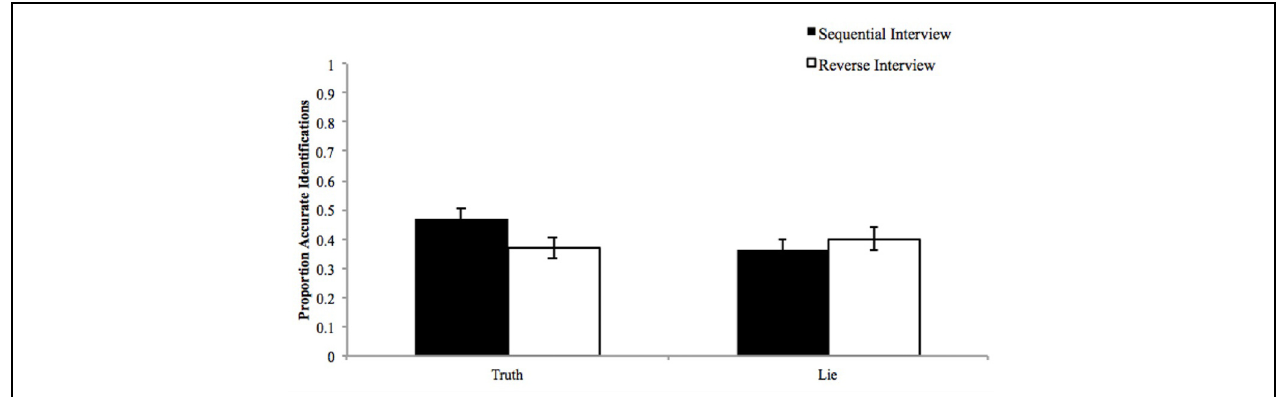
FIGURE 1 | The proportion of accurate identifications as a function of veracity and interview condition. An accurate true identification implies that observers responded “true” when the participant was telling the truth. An accurate lie identification implies that observers responded “lie” when the participant was telling a